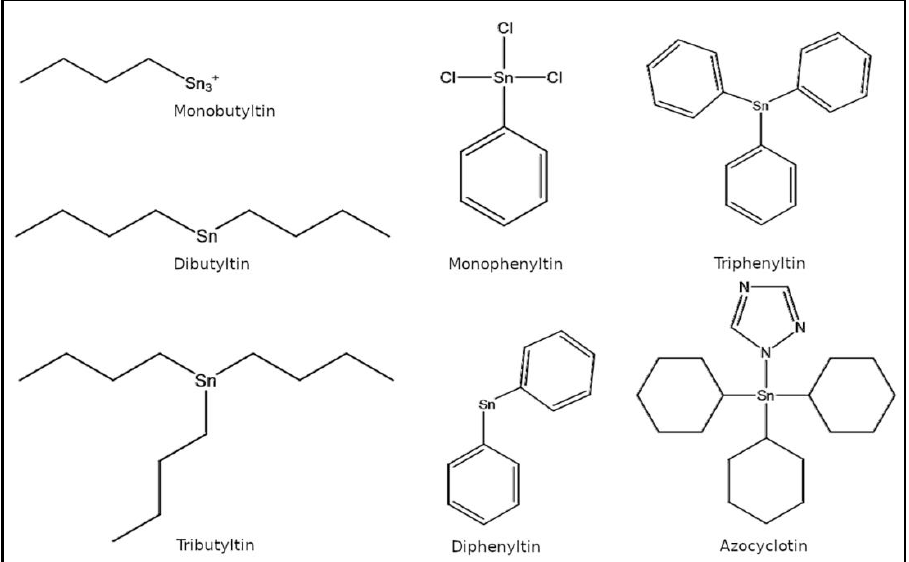
Figure 1. Two-dimensional structures of organotin compounds.